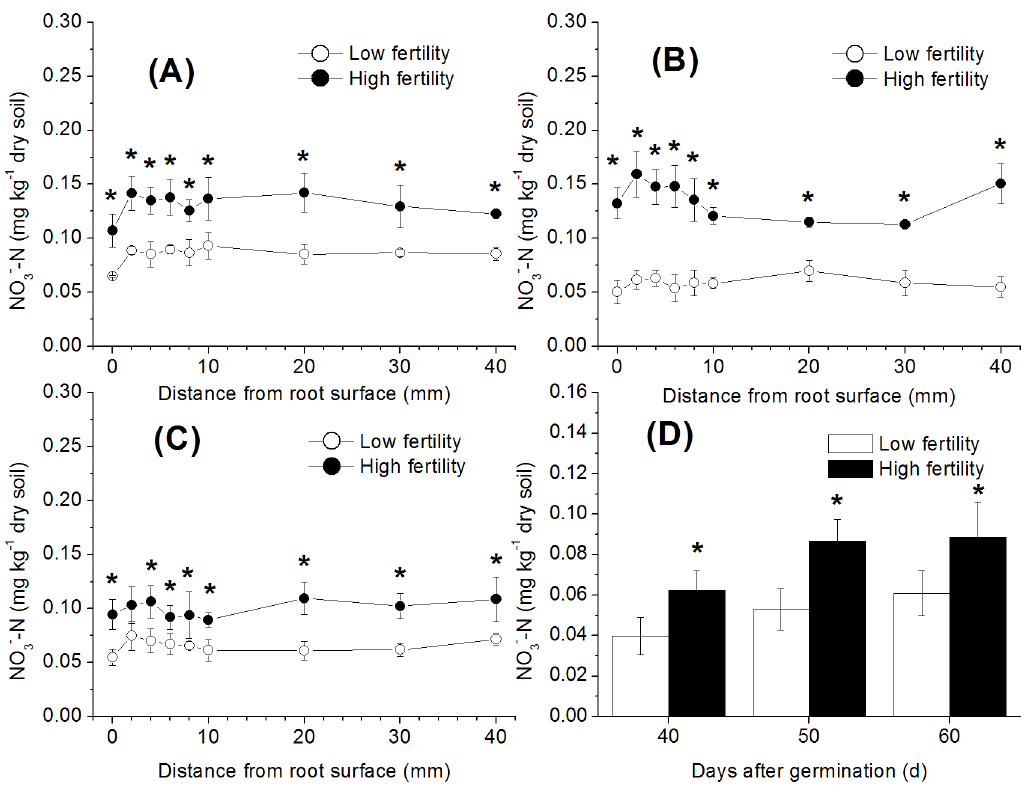
Figure 2. NO 3 2 -N measured at various distances from the rice root surface in paddy soils with different fertility levels (A) 40 d after germination, (B) 50 d after germination, and (C) 60 d after germination, relative to the (D) control (without rice plants). The bars indicate 6 SD. Dots and bars with * indicate a significant difference (p , 0.05) between the two fertility levels.